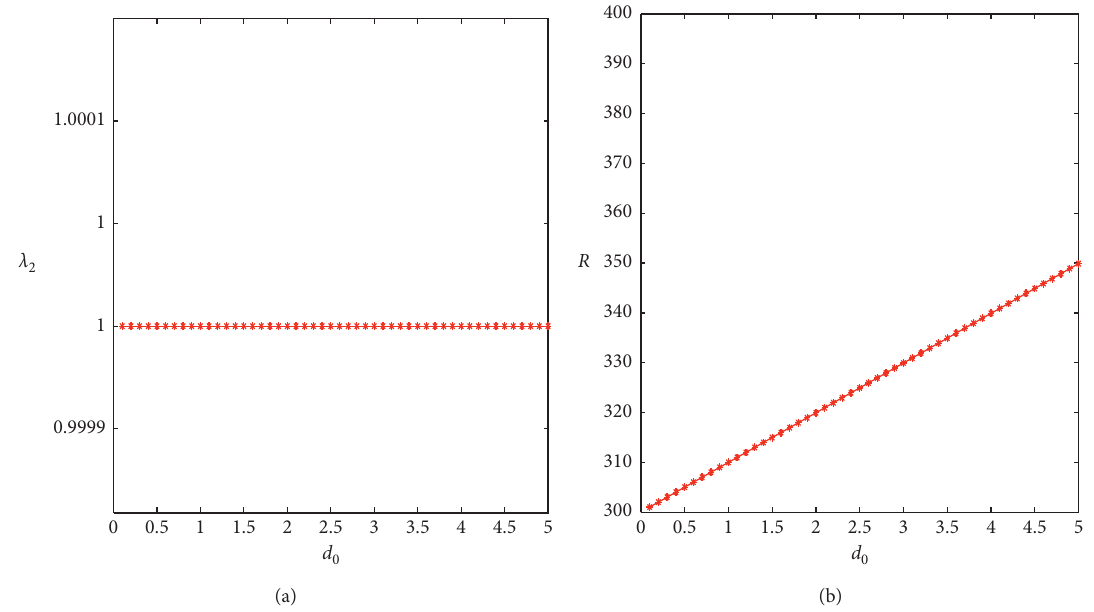
� 300, M � 10, a � 1, d � 1, and 0 ( N